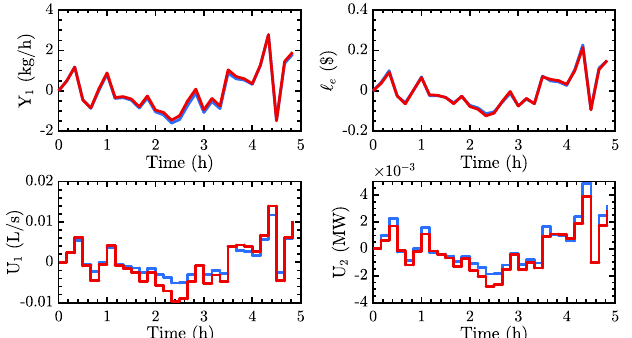
Figure 15. CO 2 emission, inputs and economic cost trajectories of the PCC plant under uncertainty in flue gas flow rate. Nominal value =1.0. Uncertainty generated by adding Gaussian white noise with zero mean and standard deviation σ = 0.1, to the flue gas flow rate. EMPC (blue), MPC (red); ( top-left ) mass flow rate of CO 2 in the treated flue gas; ( top-right ) economic performance of controller; ( bottom-left ) volumetric flow rate of solvent; ( bottom-right ) heat input to reboiler.